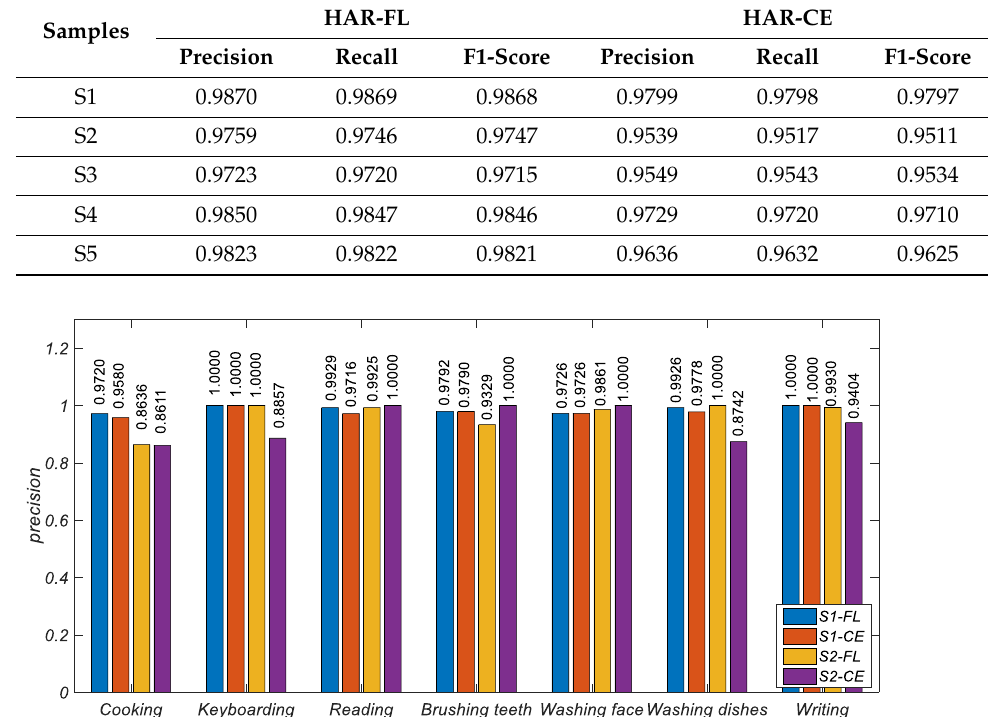
Table 7. Comparison of HAR-CE and HAR-FL.